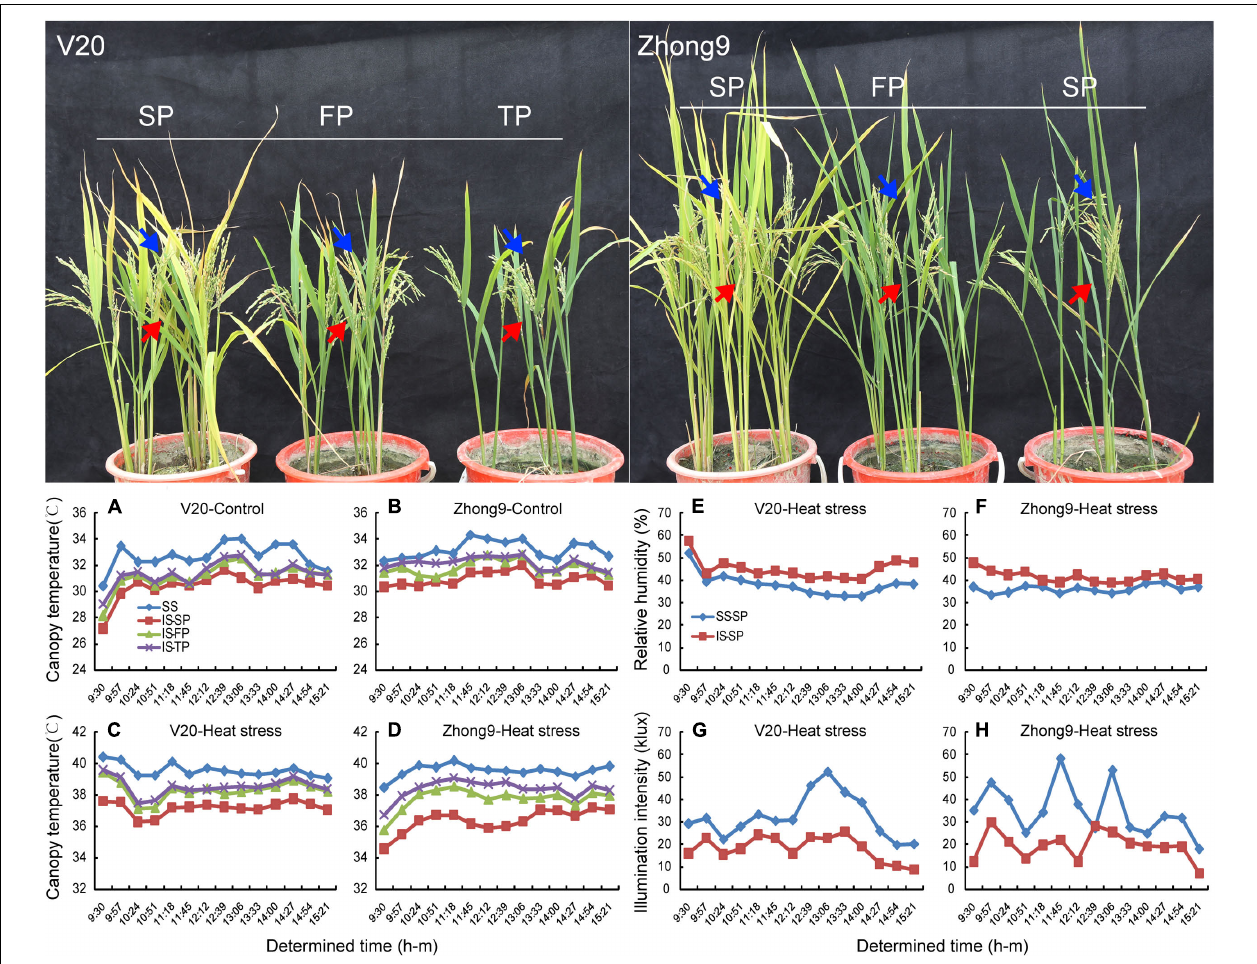
FIGURE 6 | The air temperature, relative humidity, and illumination intensity determined in the canopy which the superior and inferior spikelets located, respectively. The arrows showed in blue represent the canopy the superior spikelets (SS) located, and the arrows showed in red represent the canopy the inferior spikelets (IS) located. (A,C,E,G) V20, (B,D,F,H) Zhong9. (A,B) were determined under natural condition, while (C–H) were determined under heat stress. SP, FP, and TP present each rice plant possessing six panicles, four panicles, and two panicles,